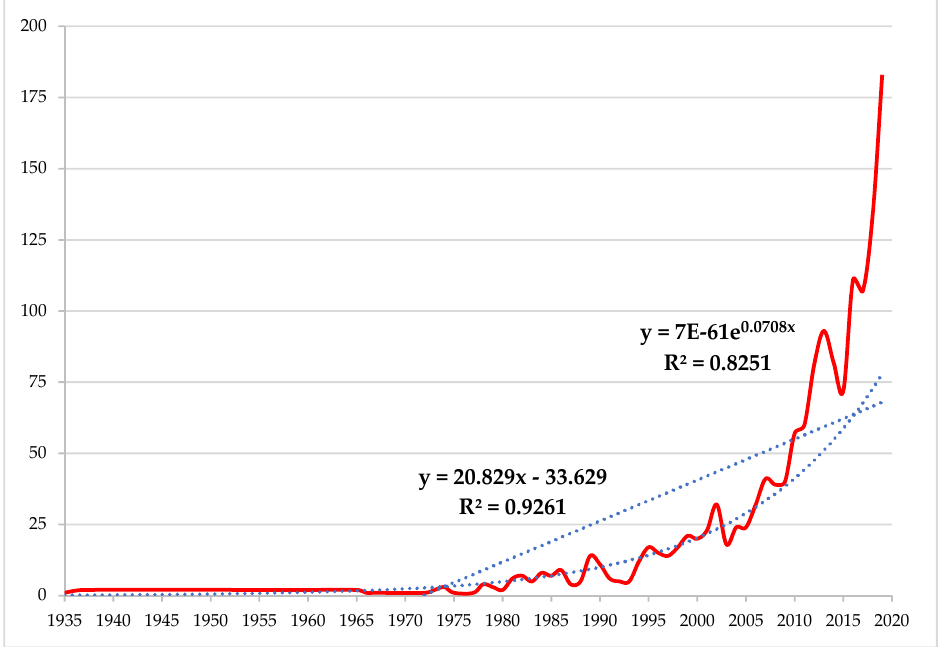
Figure 3. Evolution of the number of articles on financial transactions (1935–2019).